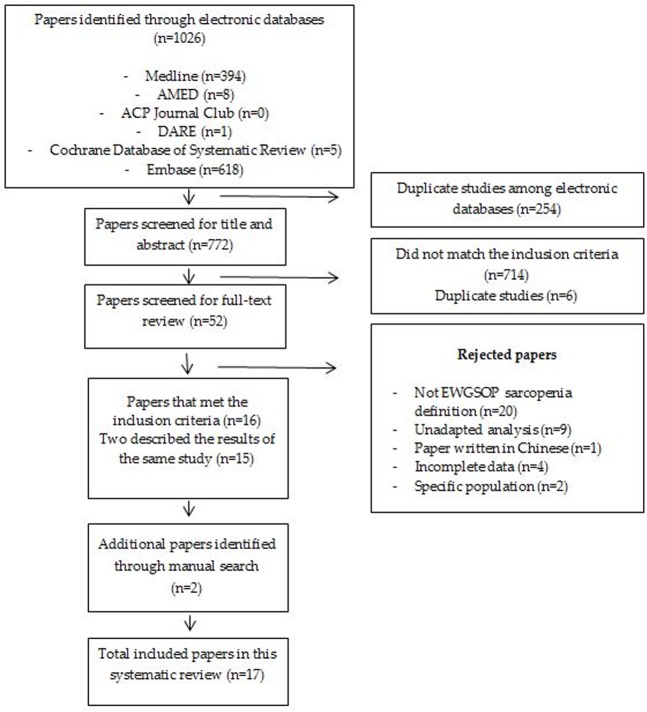
Search strategy.